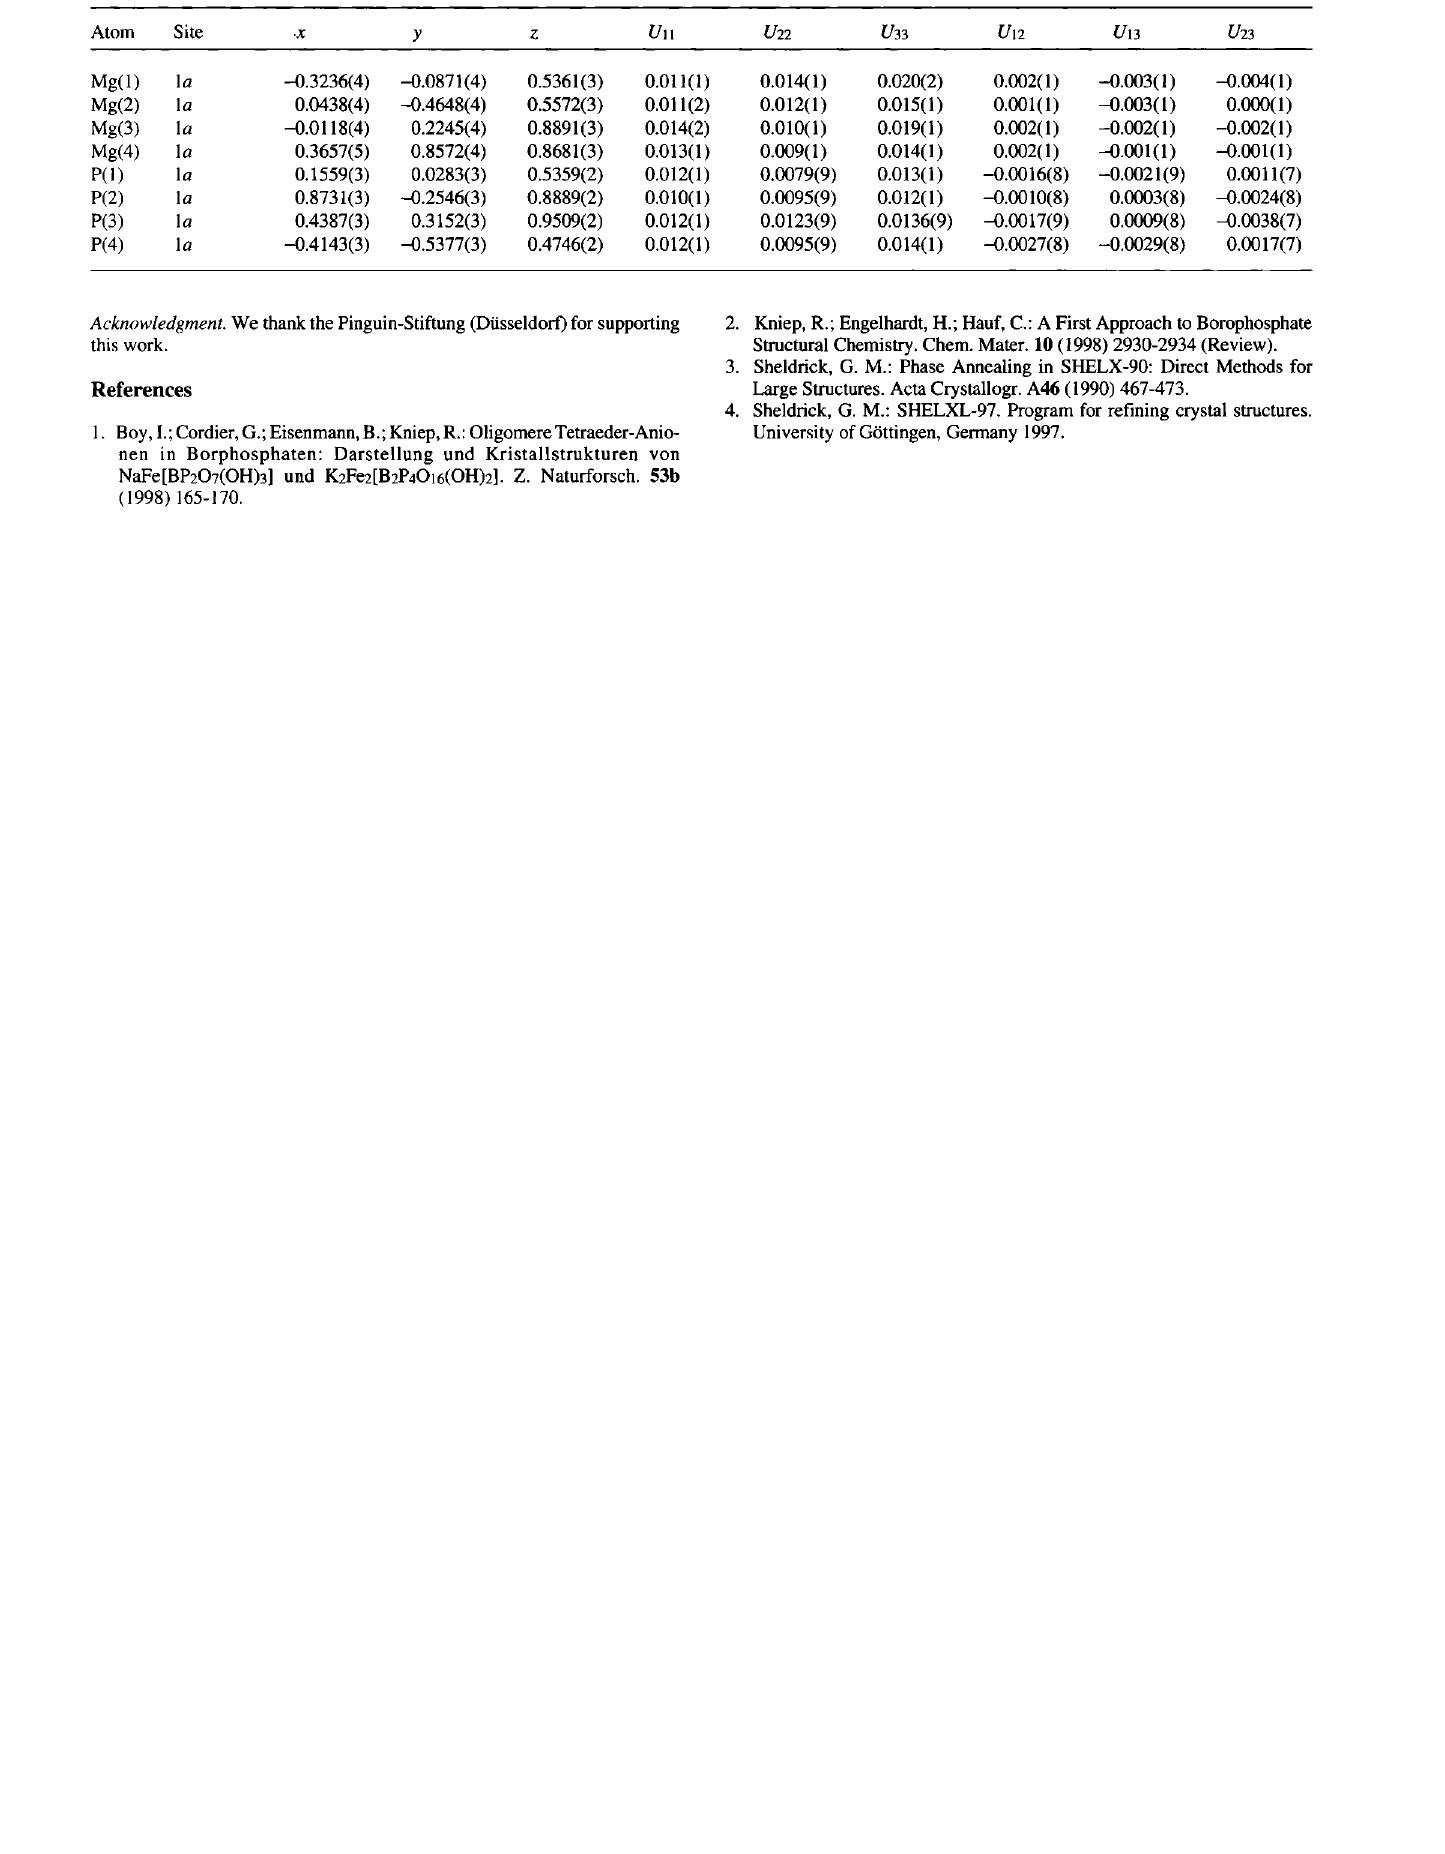
Table 3. Atomic coordinates and displacement parameters (in Â 2